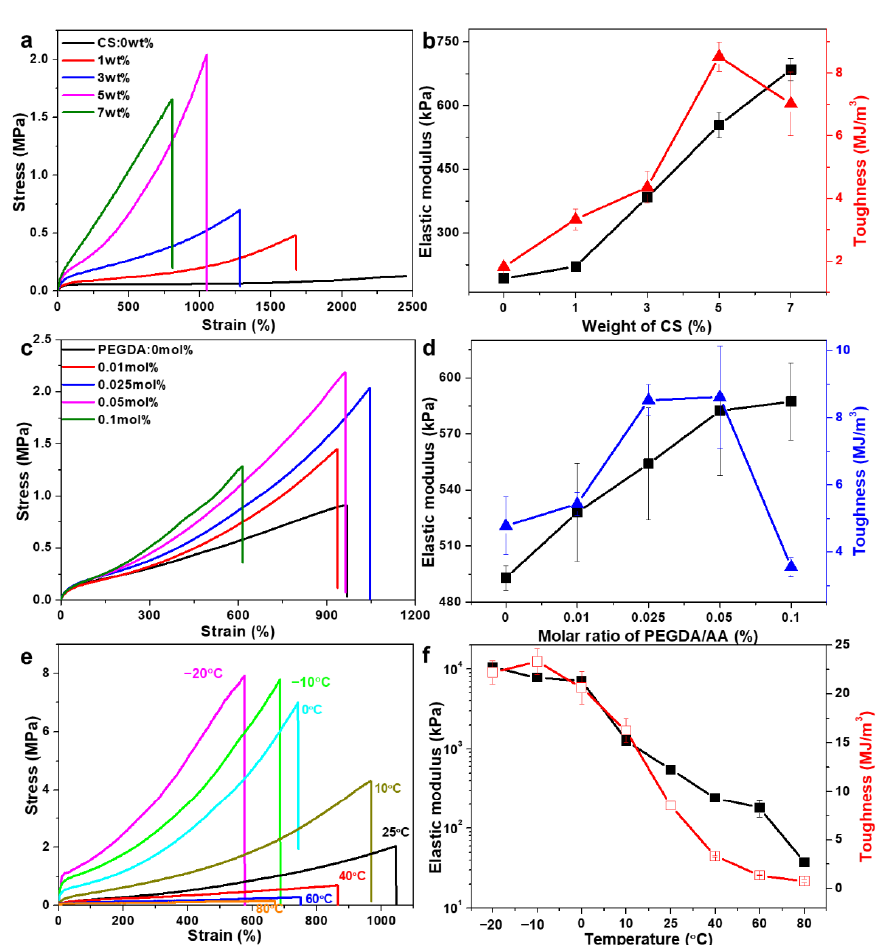
Figure 5. Tensile properties of the CS/PAA DN ionogels: tensile stress – tensile strain curves ( a ) and the corresponding elastic modulus (square) and toughness (triangle) values ( b ) of the ionogel with different contents of CS (weight fraction to AA); tensile stress – tensile strain curves ( c ) and the corresponding elastic modulus (square) and toughness (triangle) values ( d ) of the ionogel with different contents of PEGDA (molar fraction to AA); tensile stress – tensile strain curves ( e ) and the corresponding elastic modulus (solid) and toughness (open) values ( f ) of the ionogel measured at different temperatures.